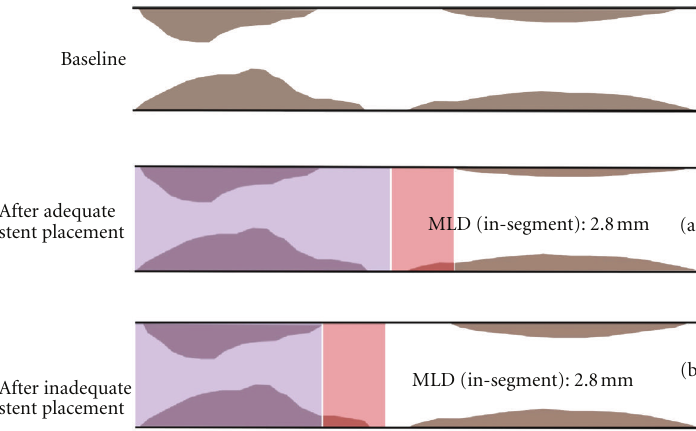
Figure 1: Inappropriate MLD description with similar MLD’s (in-segment): (a) in-segment MLD (red area) arising from nontarget lesion tissue in a case after adequate stent placement (purple area) (b) in-segment MLD from in-target-lesion tissue in a case of inappropriate stent landing zone.